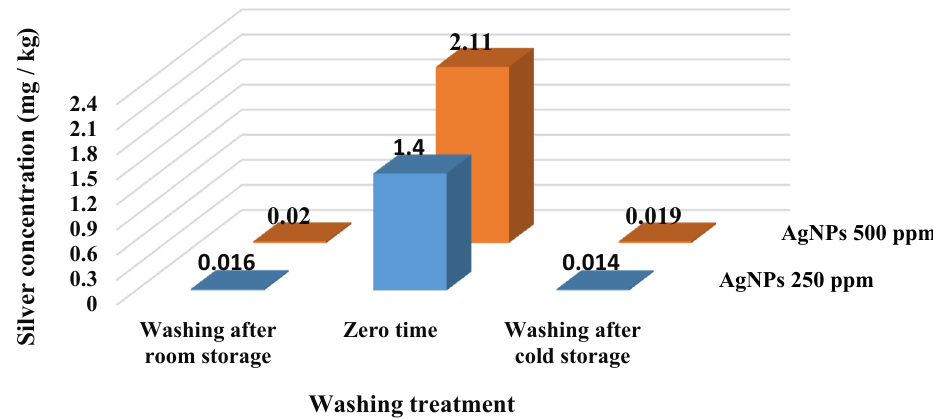
Figure 5. Analysis of the effect of the washing process on silver removal by the inductively coupled plasma-optical emission spectrometer (ICP-OES).